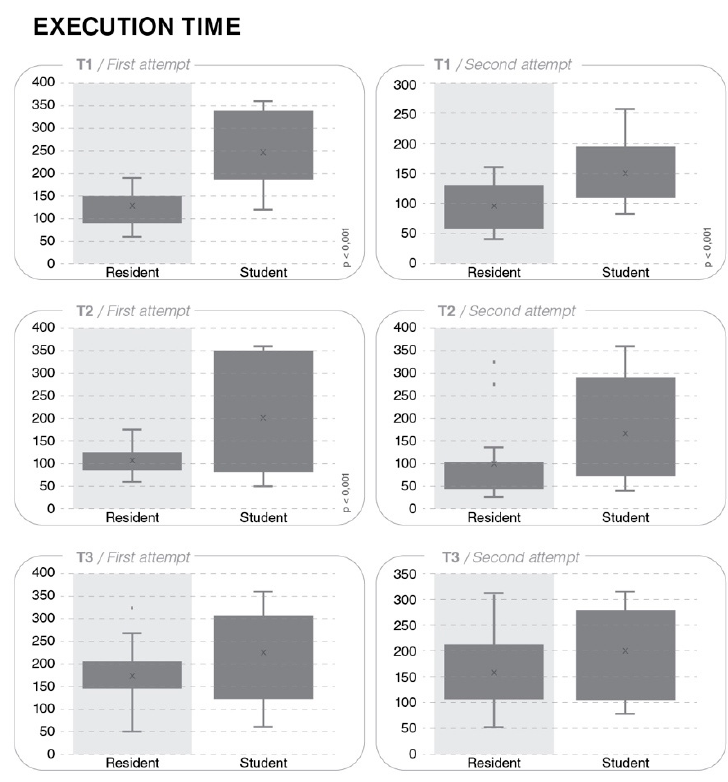
Figure 3. Mean execution time ( ± SD) for tasks T1–T3.